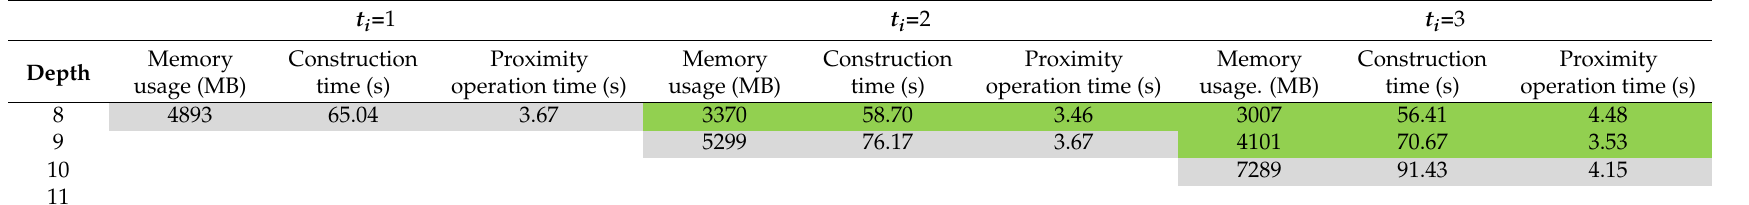
Table 12. Performance comparison among isometric octree groups using Data